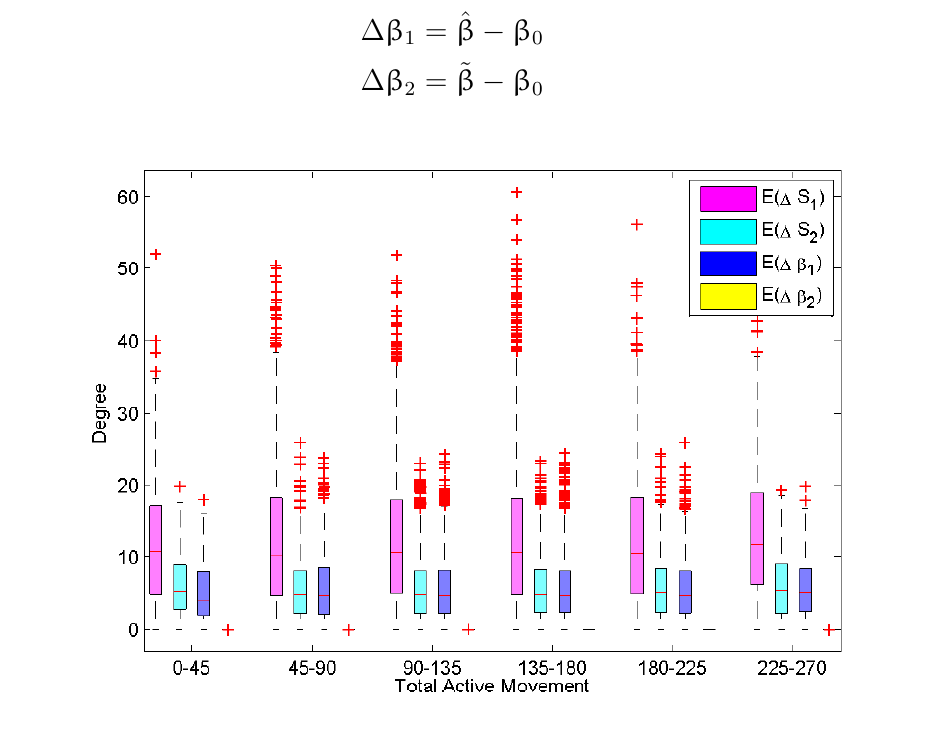
Figure 6. Simulation results for the accuracy improvement of the TAM and proximal interphalangeal joint